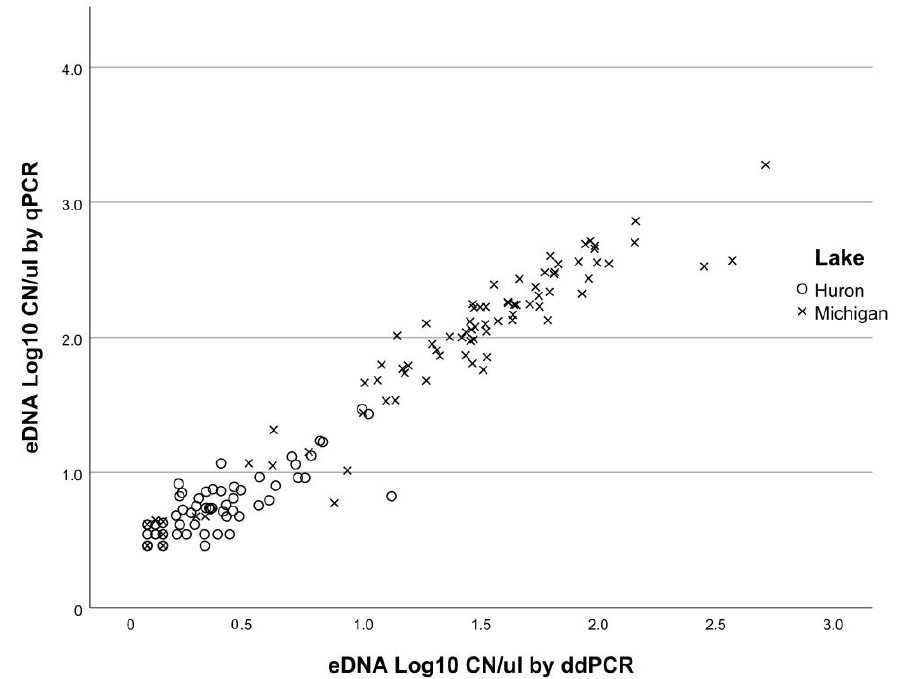
Figure 2. Round goby ( Neogobius melanostomus ) environmental DNA (eDNA) concentrations (log 10 copy number per microliter (CN/ µ L)) by droplet digital PCR (ddPCR) and quantitative PCR (qPCR) for Lake Huron and Lake Michigan water samples (N = 189).